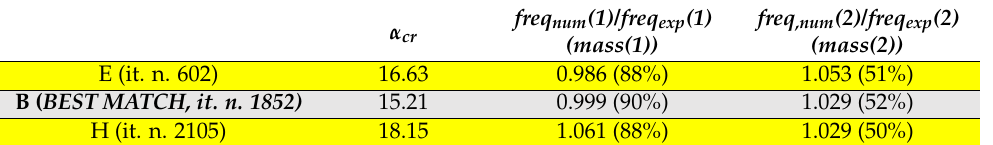
Table 3. Key design data related to models E, B and H.